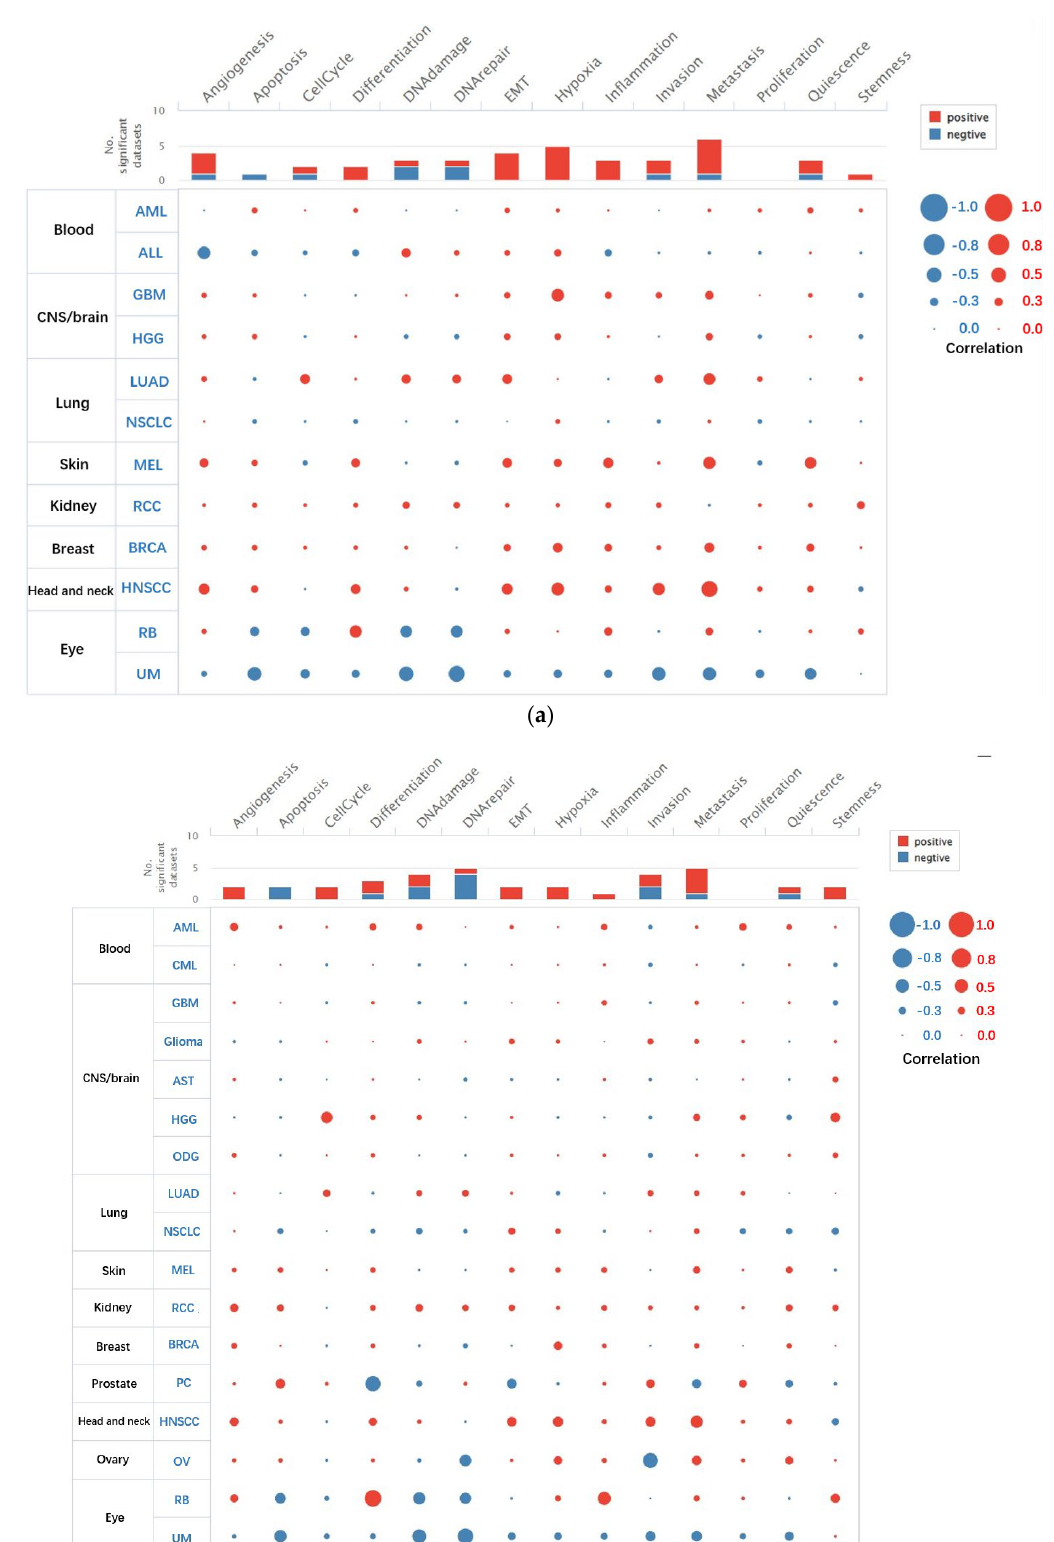
Figure 1. Functions of CAV1 and CAV2 in a single HNSC. Functional correlation analysis via CancerSEA shows that the functional phenotypes of CAV1 ( a ) and CAV2 ( b ) are moderately correlated with HNSCC.